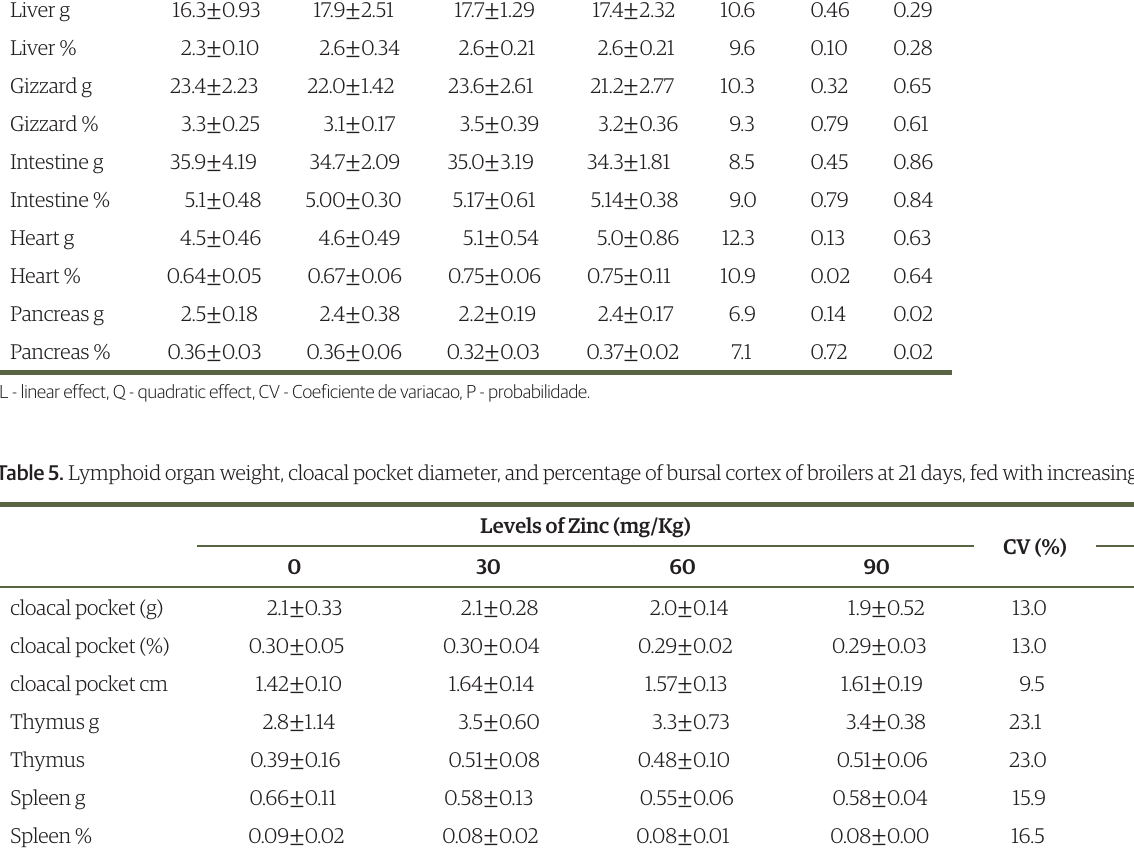
Table 4. Gut weight of 21-day-old broilers fed organic zinc levels. Levels of Zinc (mg/Kg) CV Víscera